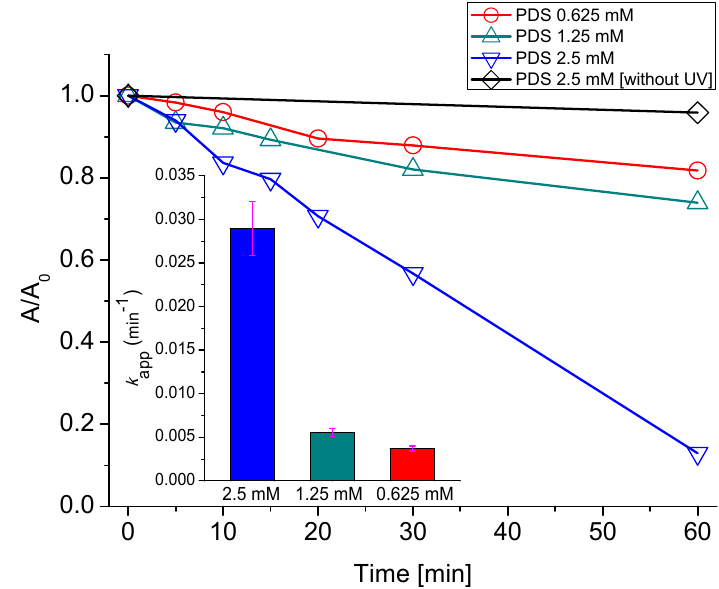
Figure 2. Decolorization (absorbance at 595 nm) of AB129 by UV/peroxydisulfate (PDS) system (25 mg/L AB129, UV 150 W). The fuchsia error bars represent the slope error The concentrations of 0.625 mM and 1.25 mM achieved only 18% and 26% decolorization,